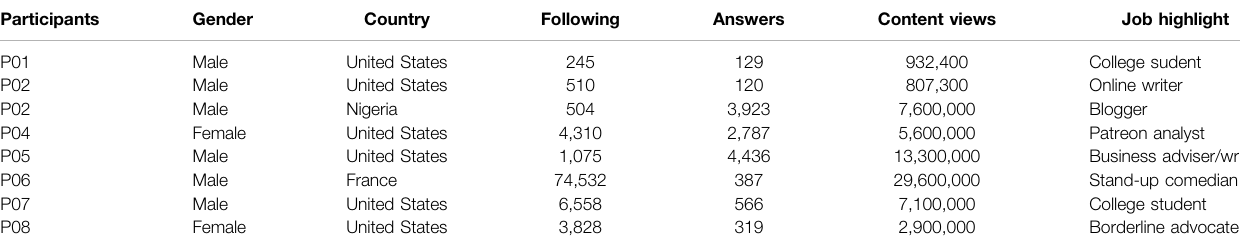
TABLE 1 | Characteristics of selected participant.